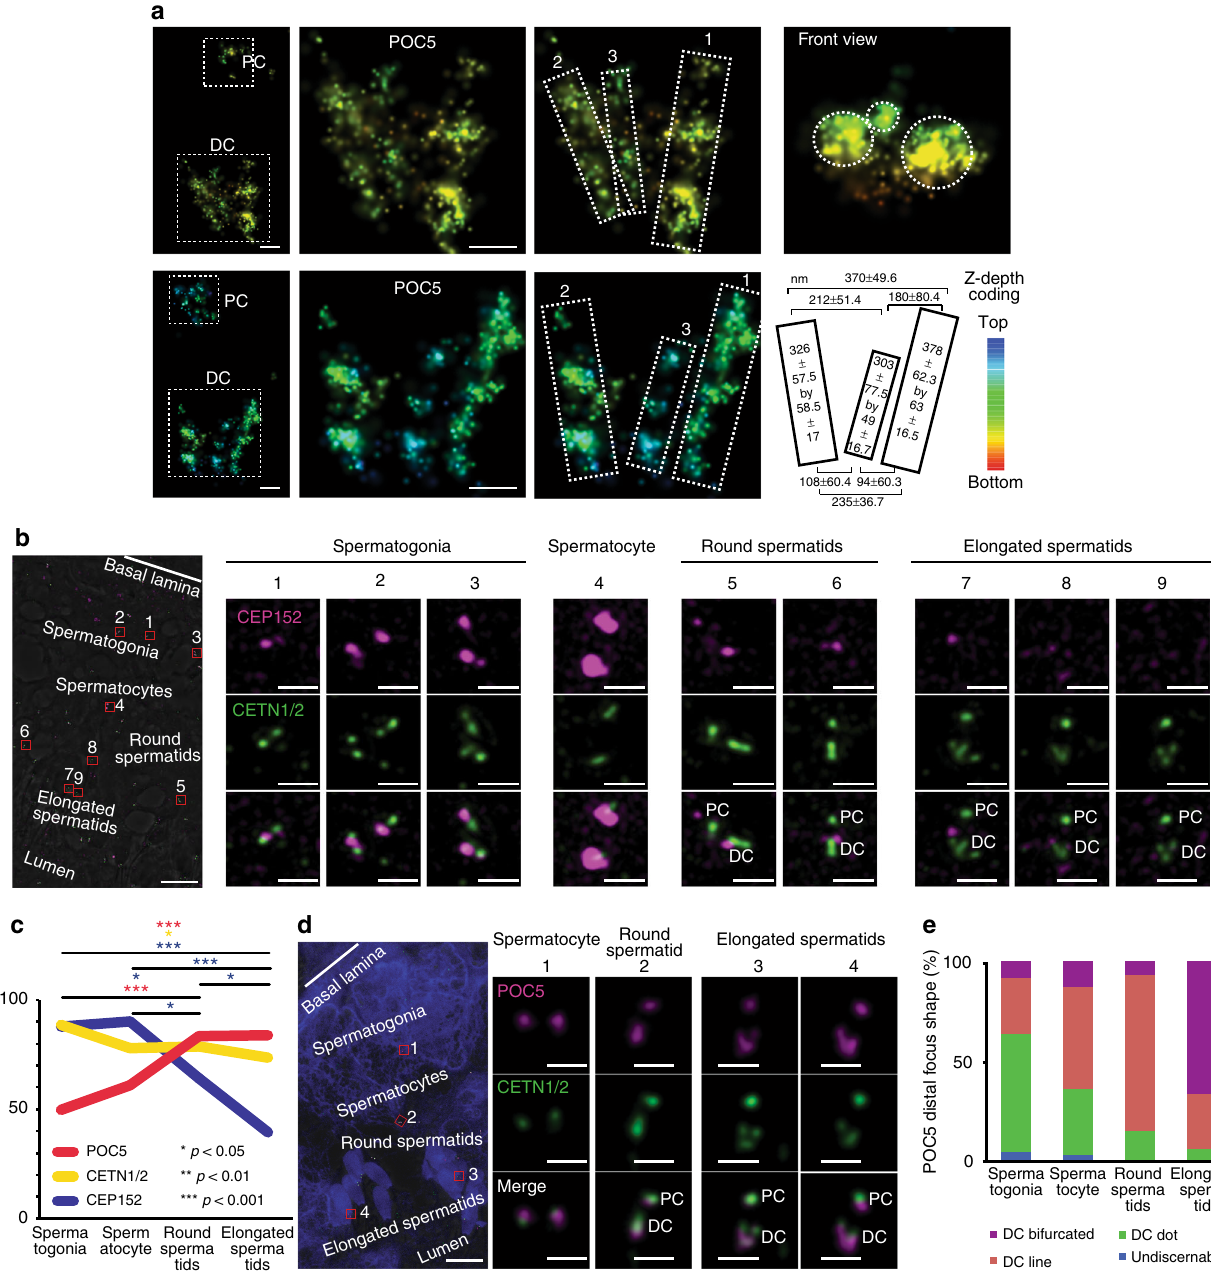
Fig. 4 POC5 and CETN 1/2 are enriched and redistributed, while CEP152 is reduced. a STORM with POC5 antibodies recognized the PC and DC (left panel). Zoom in on the DC (two middle panels) identi fi es two major rods (marked as “ 1 ” and “ 2 ” ) and one minor rod (marked as “ 3 ” ). A diagram (second row, right panel) depicting the dimensions of the rods and their distances from each other (from center to center) at their tips and bases ( N ≥ 7). Scale bar 100 nm. b A section of a seminiferous tubule (left panel) depicting the changes in CEP152 (pink) and CETN1/2 (green) in various stages (cells are numbered 1 – 9). During spermatogenesis, CEP152 and CENT1/2 localizes to 2 – 4 foci in spermatogonia (cells 1 – 3). In spermatocytes, CEP152 is maintained, often in large foci surrounding much smaller CENT1/2 lines (cell 4). In round spermatids, CEP152 is localized to the ends of elongated CENT1/2 foci and reduces into two small foci straddling the CENT1/2 line (cells 5 – 6). Finally, in the elongated spermatids (cells 7 – 9), CEP152 is localized to the tips of the CENT1/2 “ V ” shape, before it is fi nally dramatically reduced. Scale bar 10 μ m in low-magni fi cation images (left), and 1 μ m in centriole high-magni fi cation images (right). c During spermatogenesis, CEP152 is dramatically reduced (blue), CETN1/2 is slightly reduced (yellow), and POC5 is enriched (red) ( N ≥ 3). p -values determined by ANOVA with Fisher ’ s LSD post hoc. d A section of a seminiferous tubule (left panel) depicting the changes in the distribution of POC5 (pink) and CETN1/2 (green) in various stages (cells 1 – 4). Both POC5 and CENT1/2 localize to dot-shaped centrioles in spermatocytes (cell 1). In round spermatids, both POC5 and CENT1/2 elongate into a DC that is longer than the PC (cell 2). Finally, in the elongated spermatids (cells 3 – 4) both CETN1/2 and POC5 appear as “ V ” shapes. Scale bar 10 μ m in low-magni fi cation images (left), and 1 μ m in centriole high-magni fi cation images (right). e Quanti fi cation of the DC shape by POC5 immunolabeling during spermatogenesis. Most spermatogonia are dot shaped; most round spermatids are elongated; and most elongated spermatids are bifurcated ( N ≥ 3, p ≤ 0.00001). p by